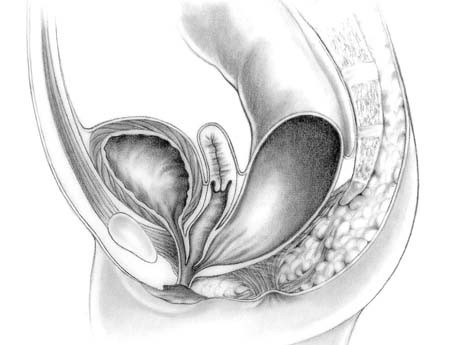
Persistent cloaca.